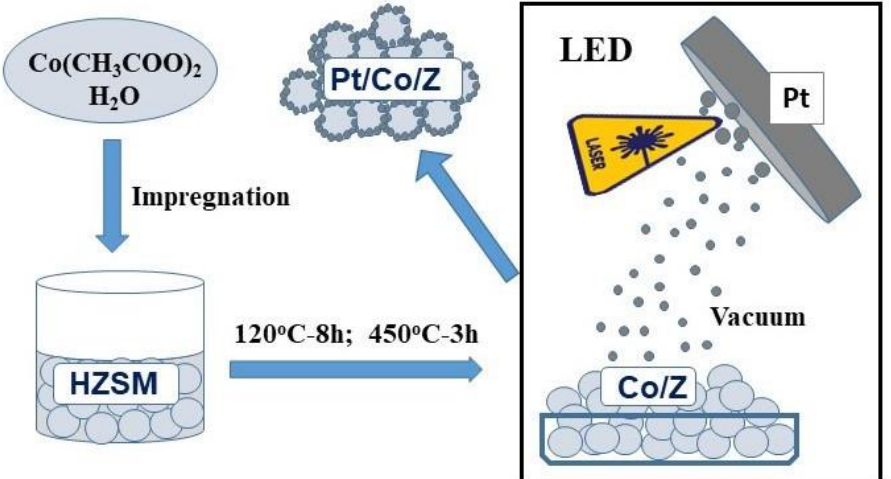
Figure 1. Schematic diagram of the catalyst preparation for the example of Pt/Co/Z.